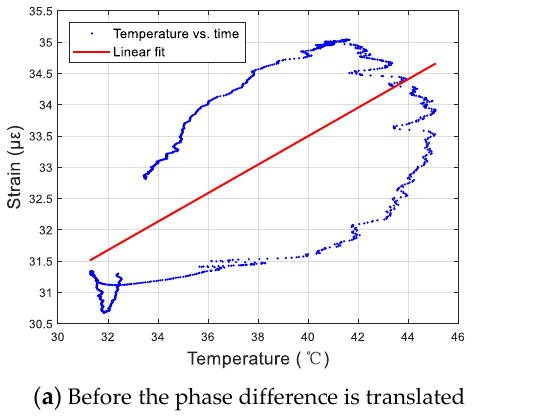
Figure 8. Temperature vs. strain plots in summer (22 July 2017).